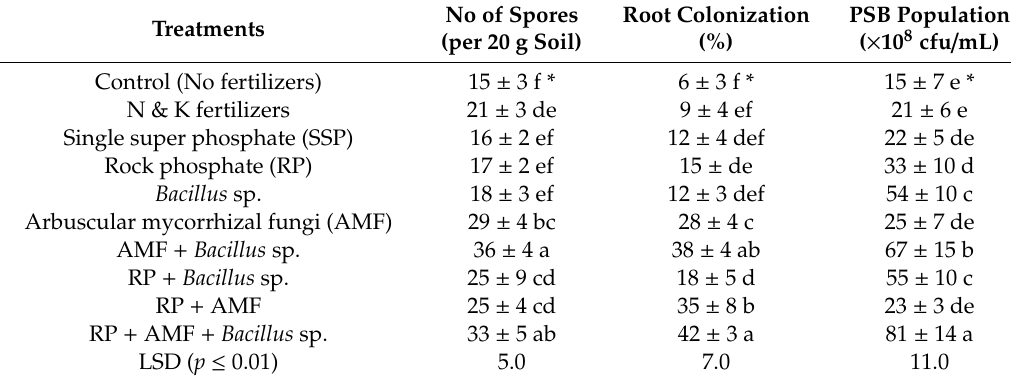
the inoculation of AMF and PSB with RP.